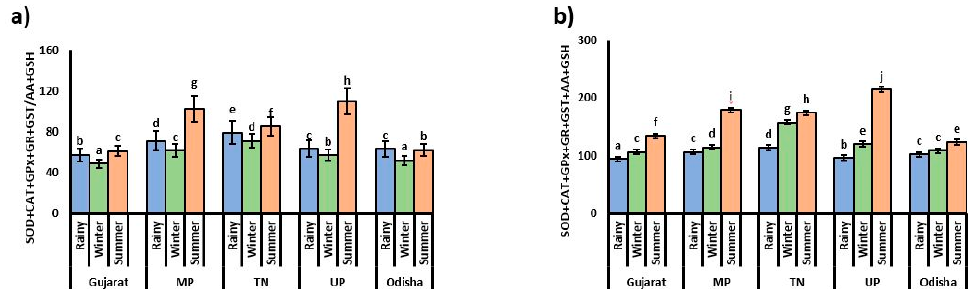
Figure 5. Seasonal variation of all measured antioxidant levels of P. globosa . ( a ) Correlation between enzymatic:non enzymatic antioxidants and ( b ) total enzymatic and non-enzymatic antioxidants with season and space. The data represent mean ± SEM with superscripts indicating statistical dif- ferences between mean values at the p < 0.05 level.